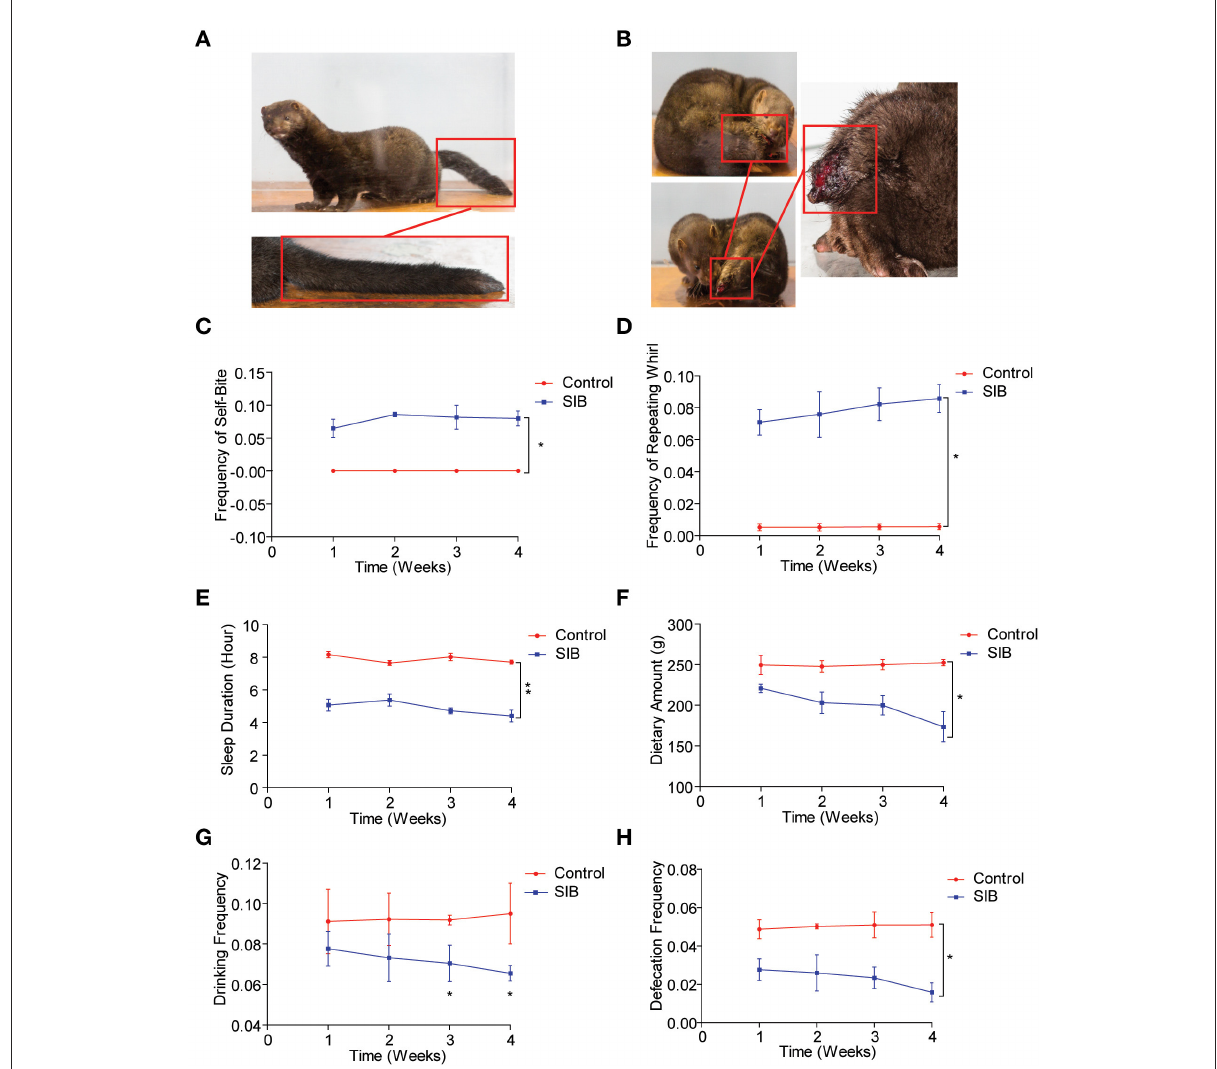
FIGURE1 Systematic behavioral observation of minks with SIB. (A) Representative images of Mink in Control Group ( n = 10). (B) Representative images of Mink in SIB Group ( n = 10). (C,D) Frequency scores for self-biting and repeating whirl during 4 week period (data are expressed as mean ± SEM; * p < 0.05. Control, n = 10; SIB, n = 8). (E–H) Scores for sleeping time, dietary amount, drinking frequency, and defecation frequency during 4 weeks (data shown represent the mean ± SEM; * p < 0.05, ** p < 0.01. Control, n = 10; SIB, n =